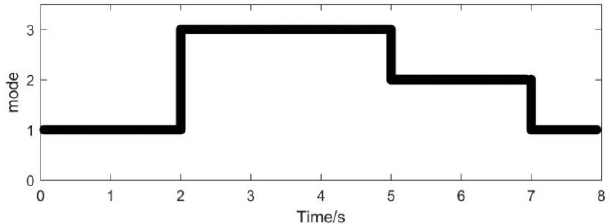
Figure 3. The switching signals σ ( k ) .